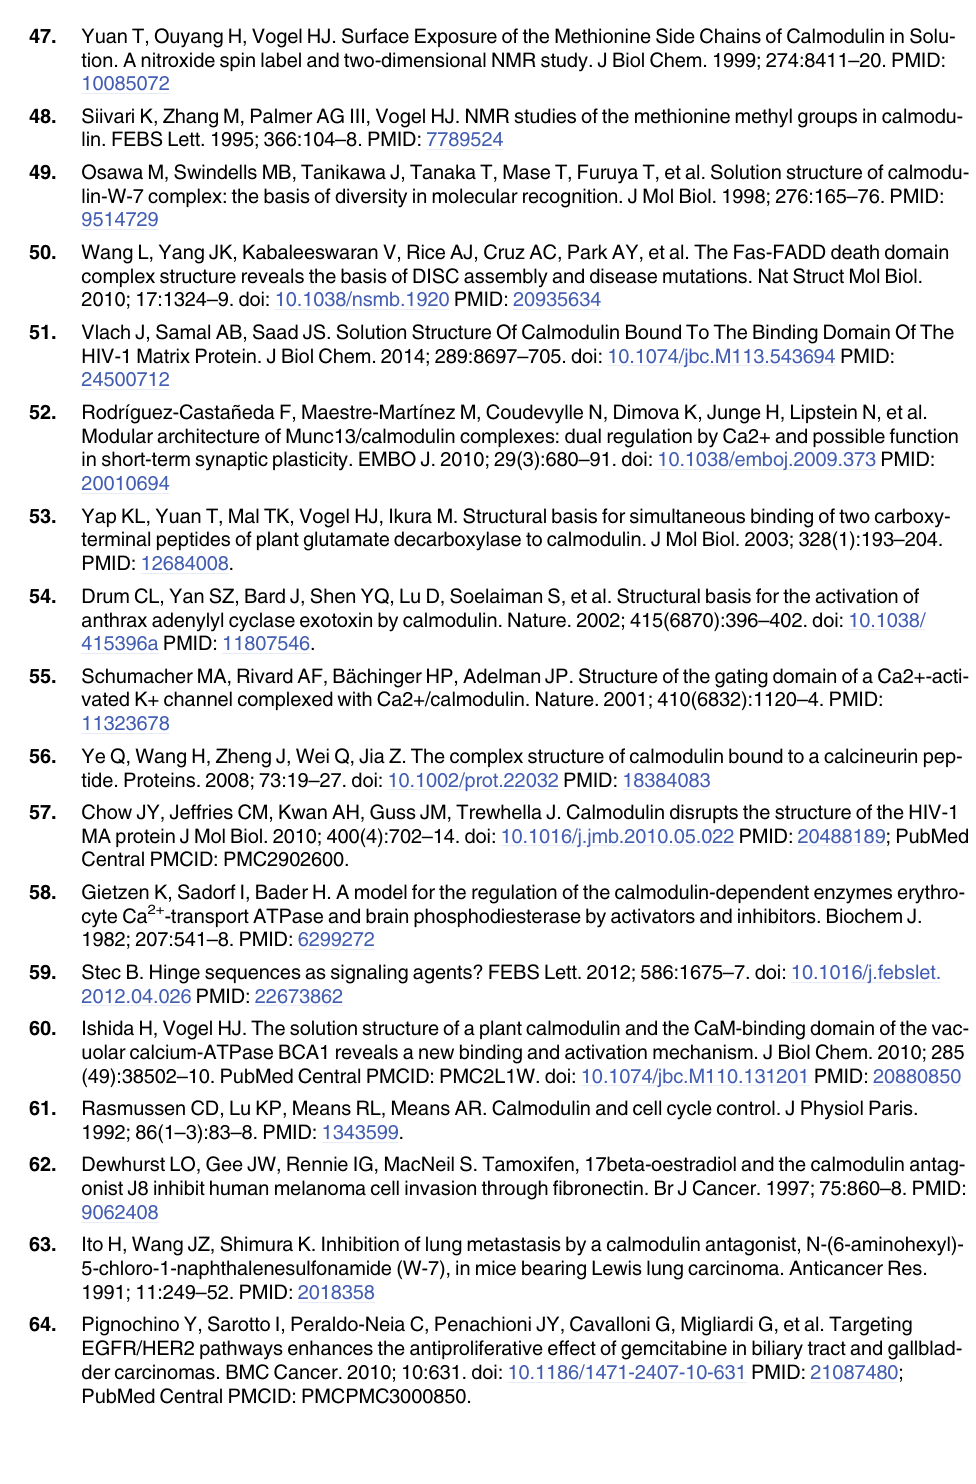
PLOS ONE | DOI:10.1371/journal.pone.0146493 January 6,